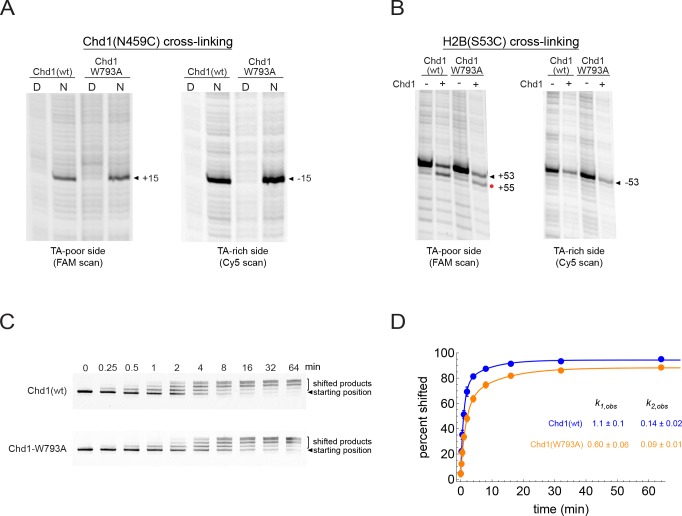
Mutation of a conserved tryptophan (W793A) in the ATPase core of Chd1 only modestly slows the rate of nucleosome sliding and does not interfere with the two nt shift of H2B(S53C).(A) The W793A mutation does not interfere with ATPase binding at SHL2. Shown are cross-linking reactions for Chd1(N459C) with and without the W793A mutation. Cross-linking was performed without nucleotide. No differences in cross-linking are apparent. (B) The W793A mutation does not disrupt the Chd1-dependent shift in H2B(S53C) cross-linking on the TA-poor side. These cross-linking reactions were carried out with the double mutant variant Chd1(N495C/W793A) under apo conditions. (C) Native gel sliding assay, showing repositioning of nucleosomes over time by wildtype Chd1 and a Chd1(W793A) variant. In this experiment, 50 nM Chd1 was incubated with 150 nM 0N80 nucleosome in the presence of 2.5 mM ATP and 5 mM MgCl2. (D) Quantitation and fitting of native gel sliding data shown in C. Colored circles are the averages of five replicates, with standard deviations shown as error bars (often obscured markers). Data were fit to a double exponential, and for the faster rate, Chd1(W793A) was approximately 2-fold slower than wild type Chd1.